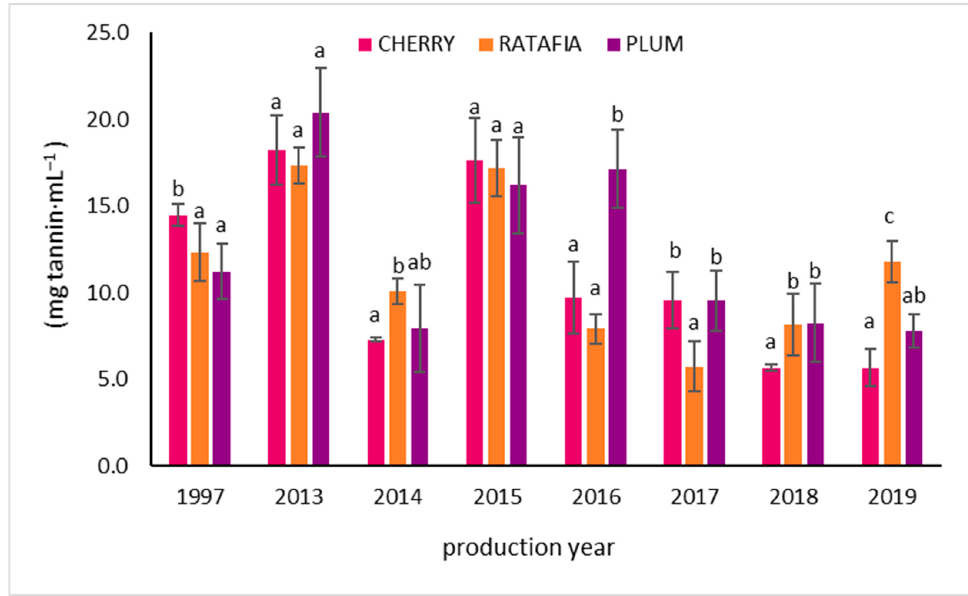
Figure 6. The tannin content of nalewkas (mean ± SD, n = 3). Different letters indicate significant differences between the nalewkas in individual years of production ( α = 0.05). The result was ex- pressed in mg tannin·mL − 1 of nalewka.